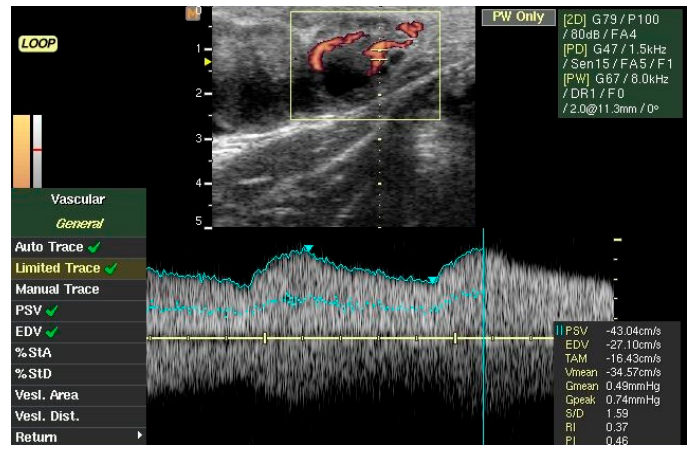
Figure 1. Corpus luteum blood flow assessment in buffaloes with the aid of eco-color Doppler mode.